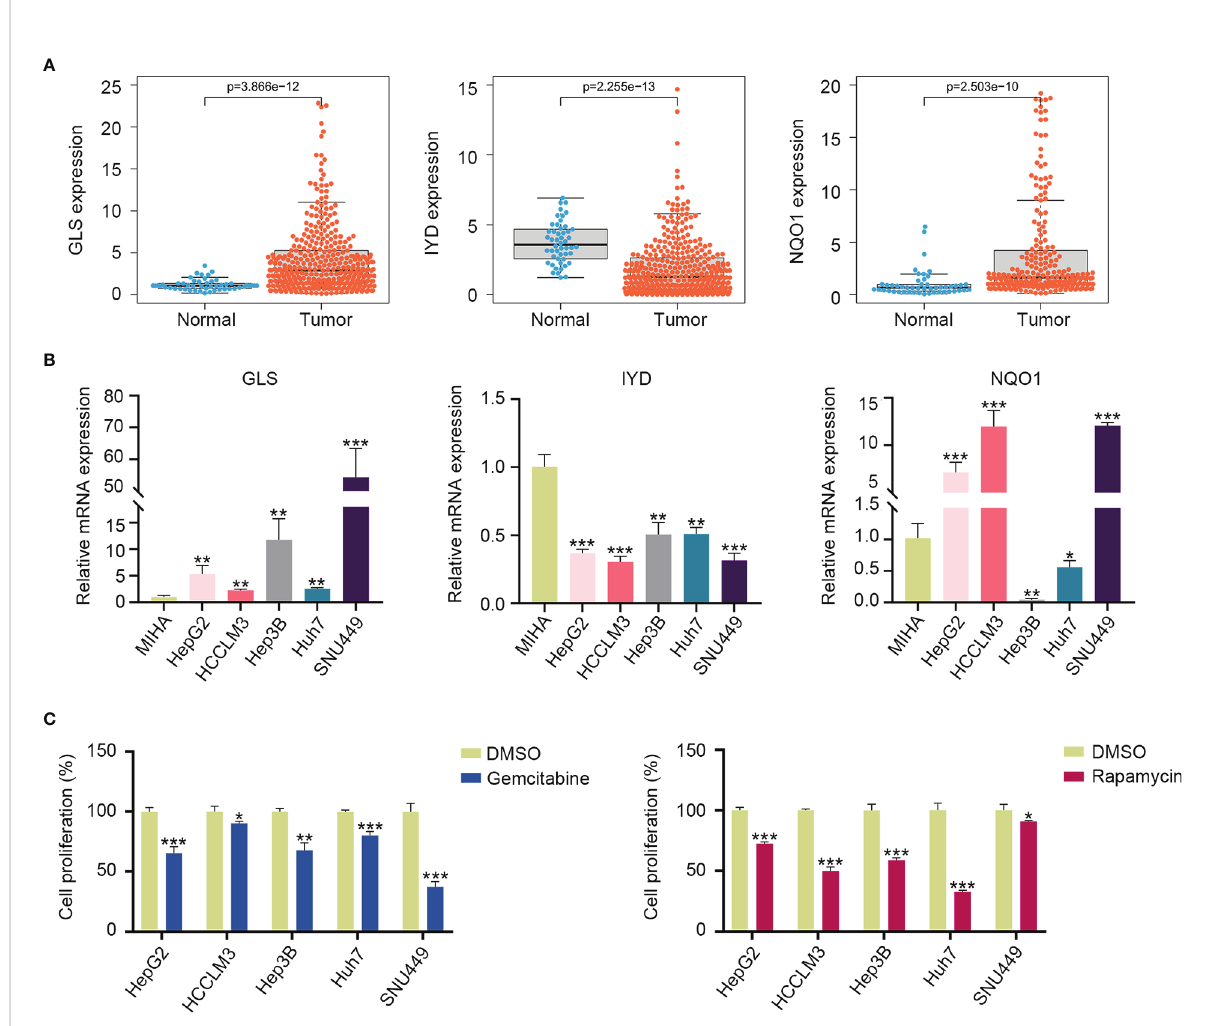
FIGURE 9 Three signature gene expressions and cell proliferation under drug treatment. (A) Expression of GLS, IYD, and NQO1 between the HCC tissues and normal tissues in the TCGA database. (B) Validation of the GLS, IYD, and NQO1 expression in the normal liver cell and liver cancer cells by quantitative real-time PCR. (C) The cell proliferation rate of liver cancer cells after 48h of rapamycin or gemcitabine treatment. *P < 0.05, **P < 0.01, ***P <